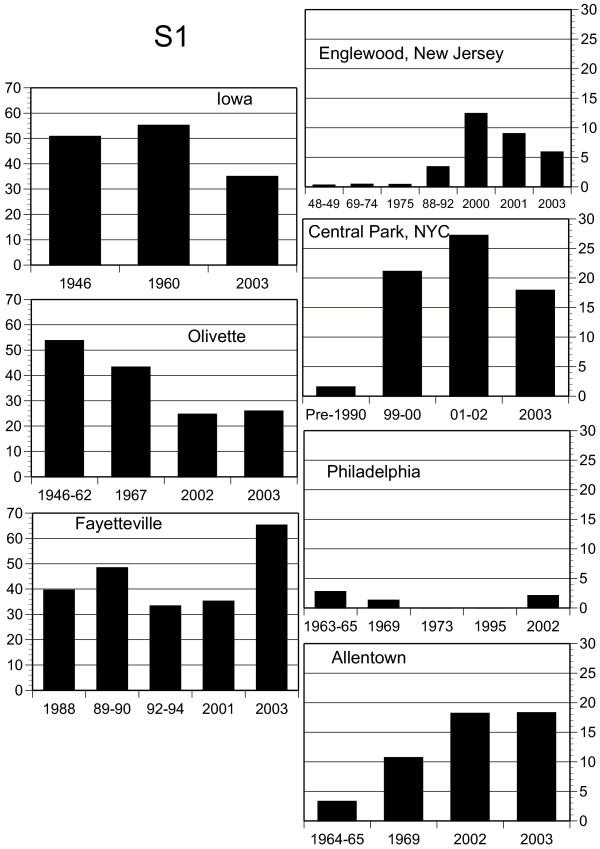
Frequencies (in percent) of D. robusta X-chromosome arrangement combination S1 in the seven study localities, including Philadelphia [18]. When frequencies across years were statistically homogeneous, they were combined within each locality. Y axes for eastern populations reflect the much lower frequencies for S1 in that part of the species range.